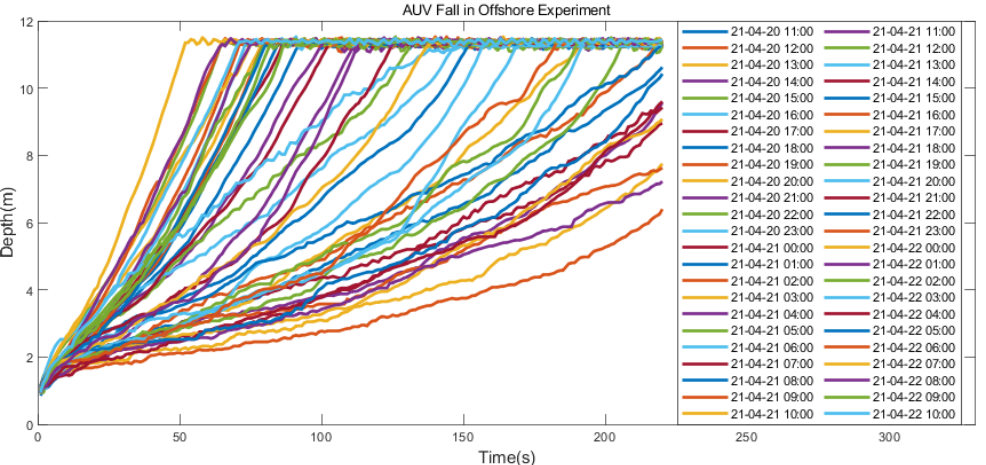
Figure 18. Offshore survey comparative experiment.